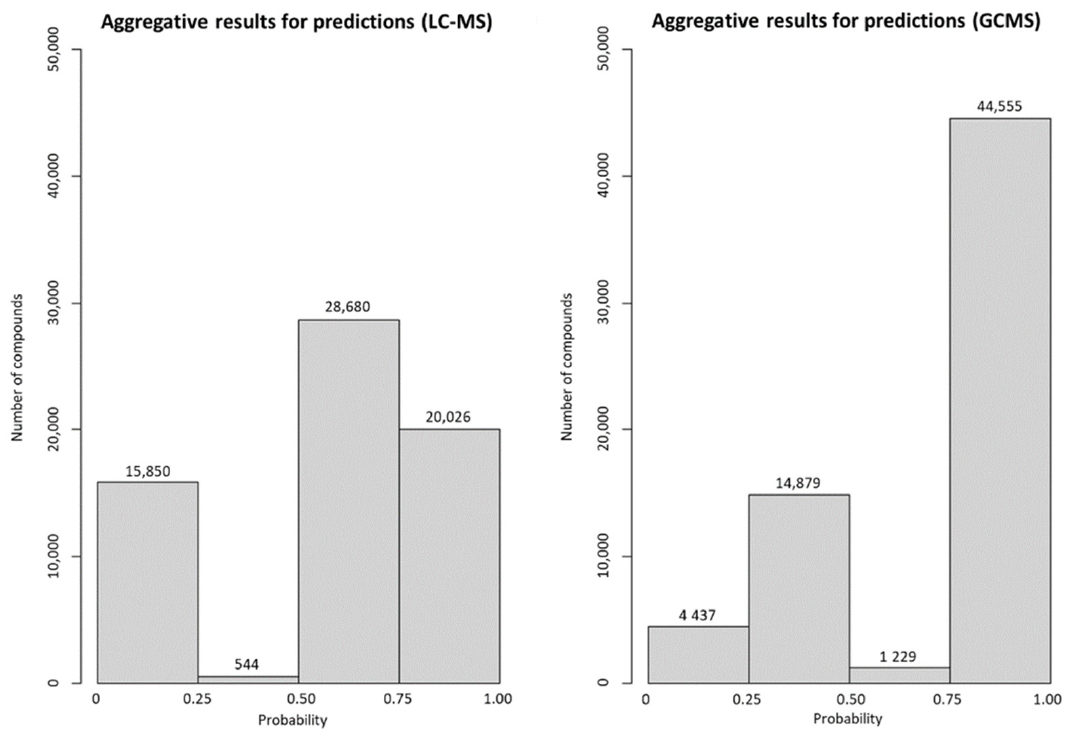
Figure 4. Aggregative results of LC ‐ MS and GC ‐ MS amenability.